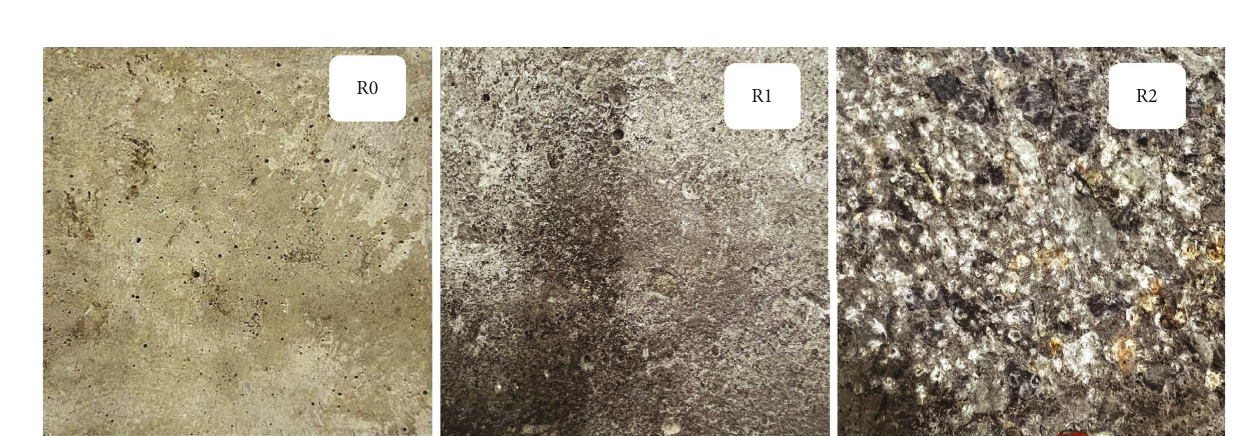
Figure 7: Bonding interface roughness